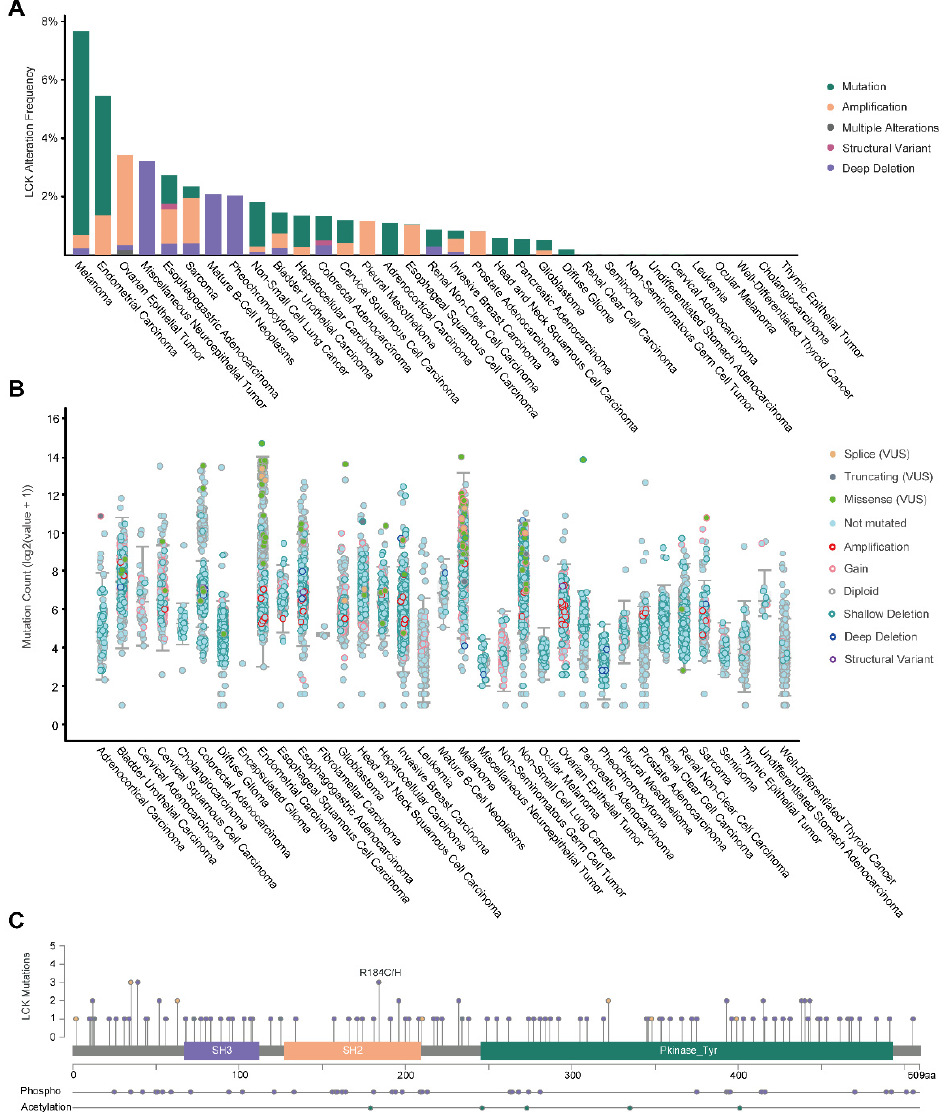
Figure 5. Genetic alteration types and protein mutations of LCK in different tumors. ( A ) LCK alteration frequency across different human tumors. ( B ) Mutation types and counts of LCK in human tumors. ( C ) Mutation diagram of LCK in different human cancers across protein domains.